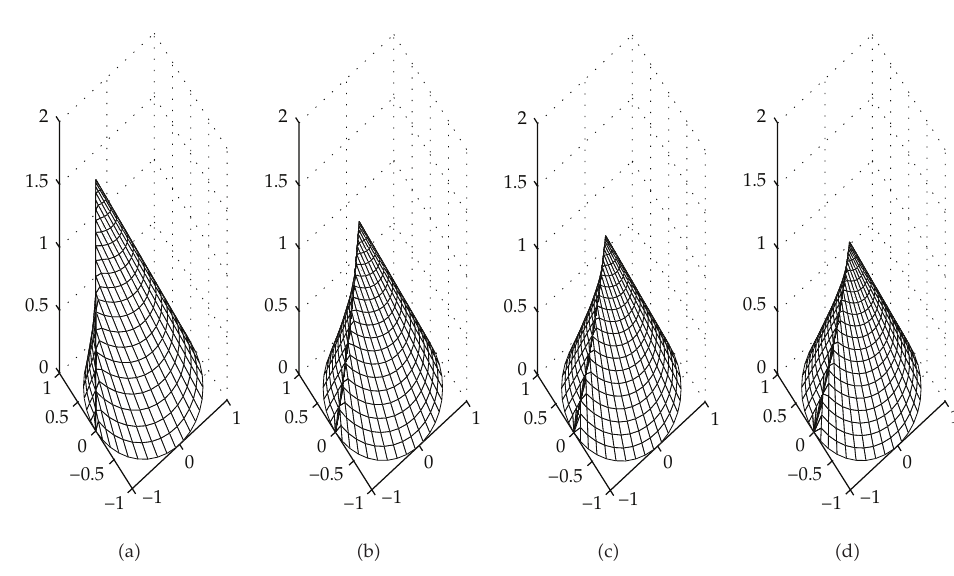
Figure 5: Stability cones for k (cid:3) 2 , 3 , 4 ,